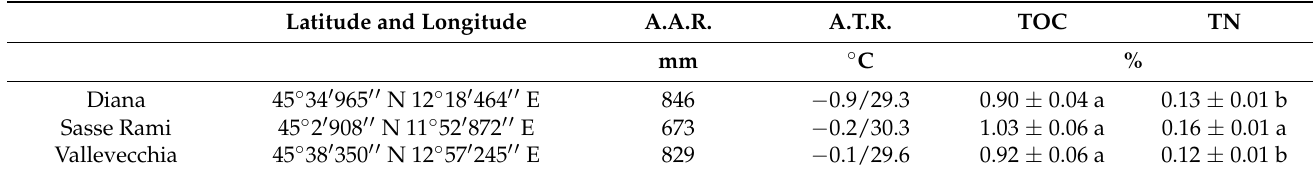
Table 1. Soil parameters of the three farms in 2011, localization of places, and climate parameters during the